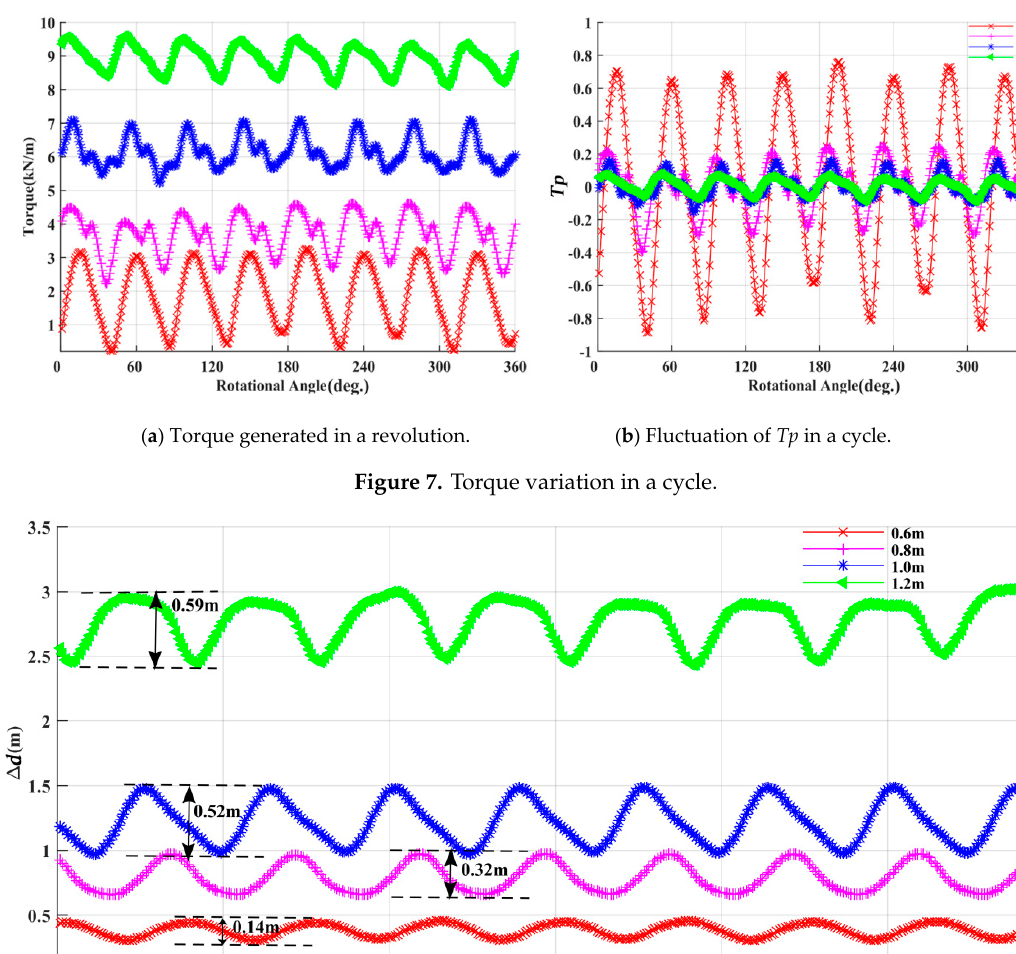
∆ d between the upstream and downstream in a cycle Figure 8. ∆(cid:1856) between the upstream and downstream in a cycle (m). Figure 8.